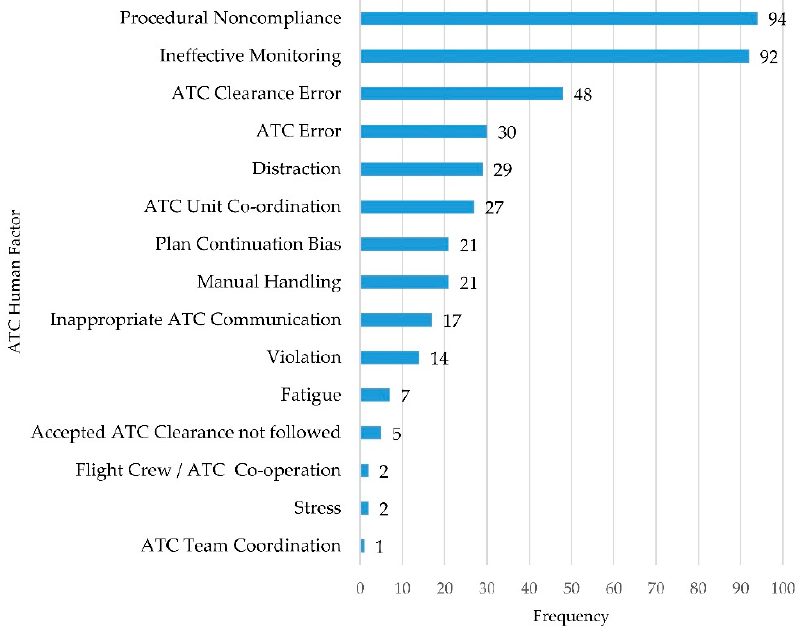
Figure 6. Distribution of ATC human factor tags in aviation accidents/incidents from 1980 to 2019.